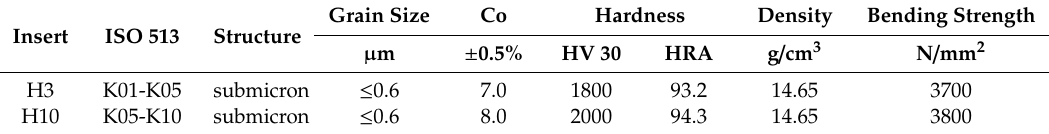
Table 4. Mechanical properties of cemented carbide